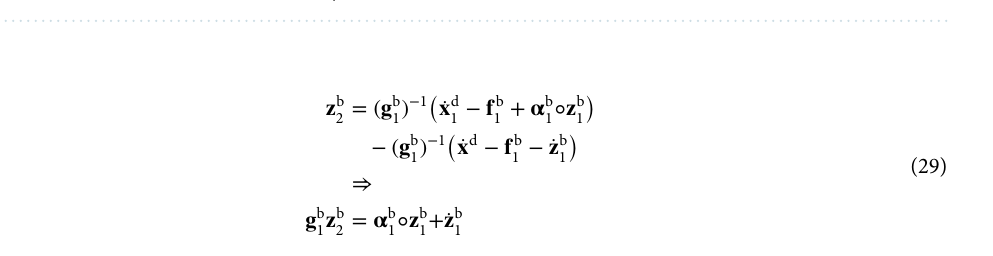
Table 2. Main module of the simulation